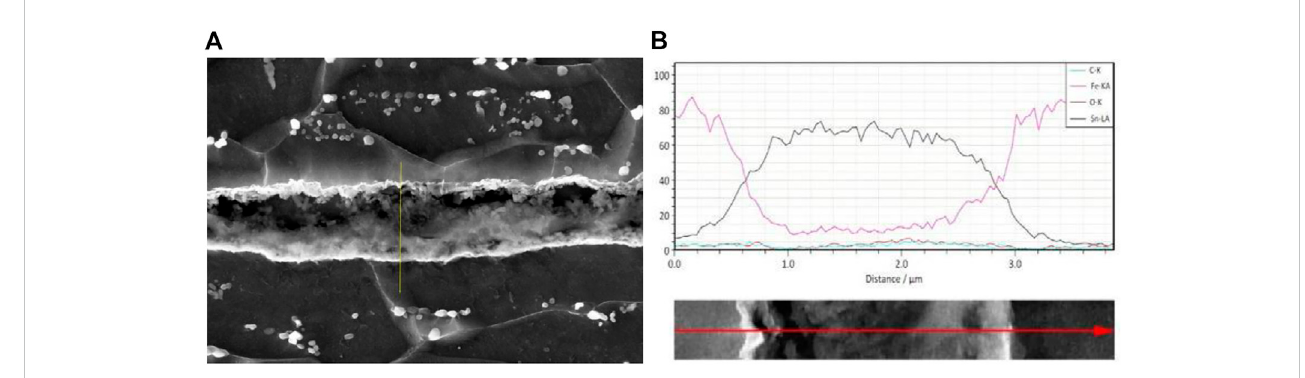
FIGURE 14 (A) SEM micrograph. (B) EDS line scan shows the presence of the